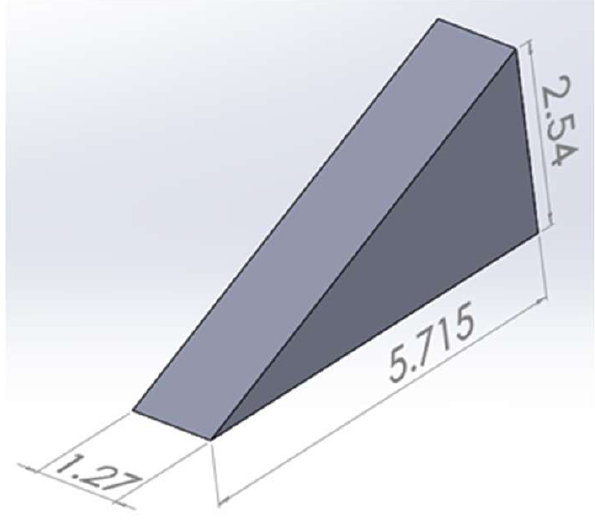
Figure 4. Front ( left ) and side ( right ) views of rack with vortex generators attached to bottom and vertical posts. Dimension shown are in meters.